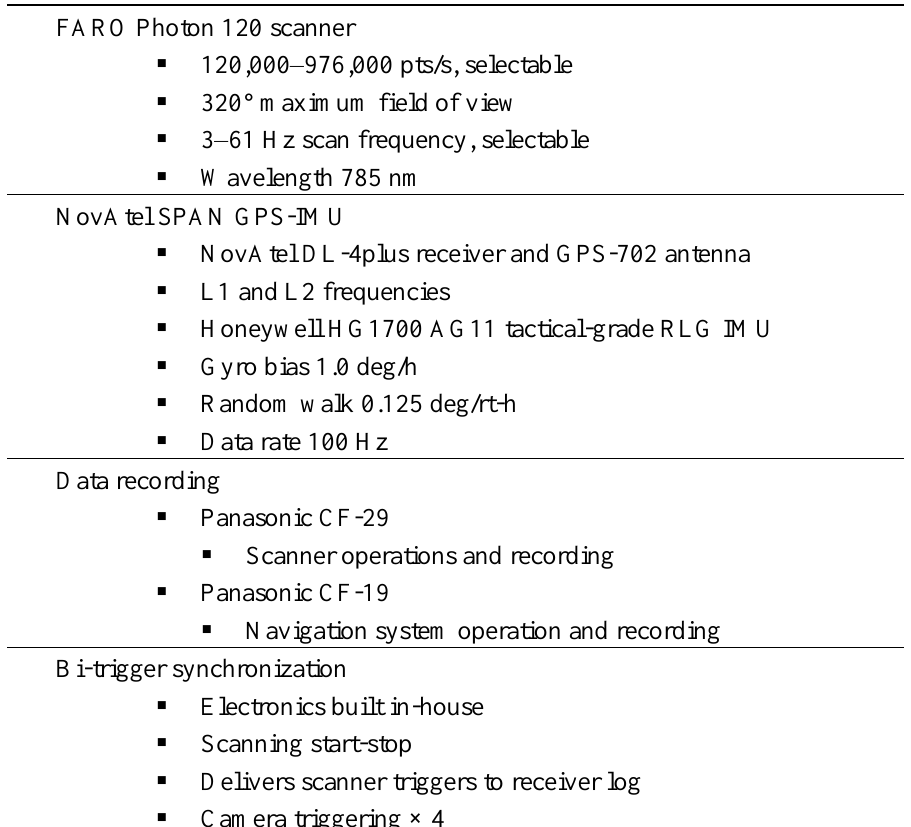
Table 1. ROAMER MLS system equipment and